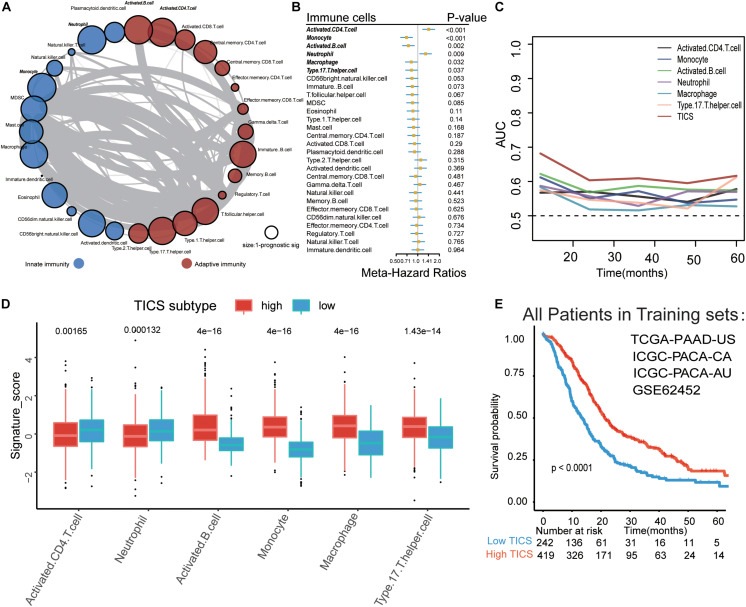
Establishment of Tumor-infiltrating immune cell score (TICS). (A) The spearman relationship within the 28 immune cells. (B) Forest plot for the prognostic values of the 28 immune cells in PDAC patients; (C) Time-dependent receiver operating characteristic curve (ROC) analysis of the six prognostic immune cells and TICS. (D) The differences of the six prognostic immune cells between the high and low TICS subgroups which stratified by the best cut-off value. (E) The Kaplan-Meier curve of the TICS subgroups in total PDAC patients.